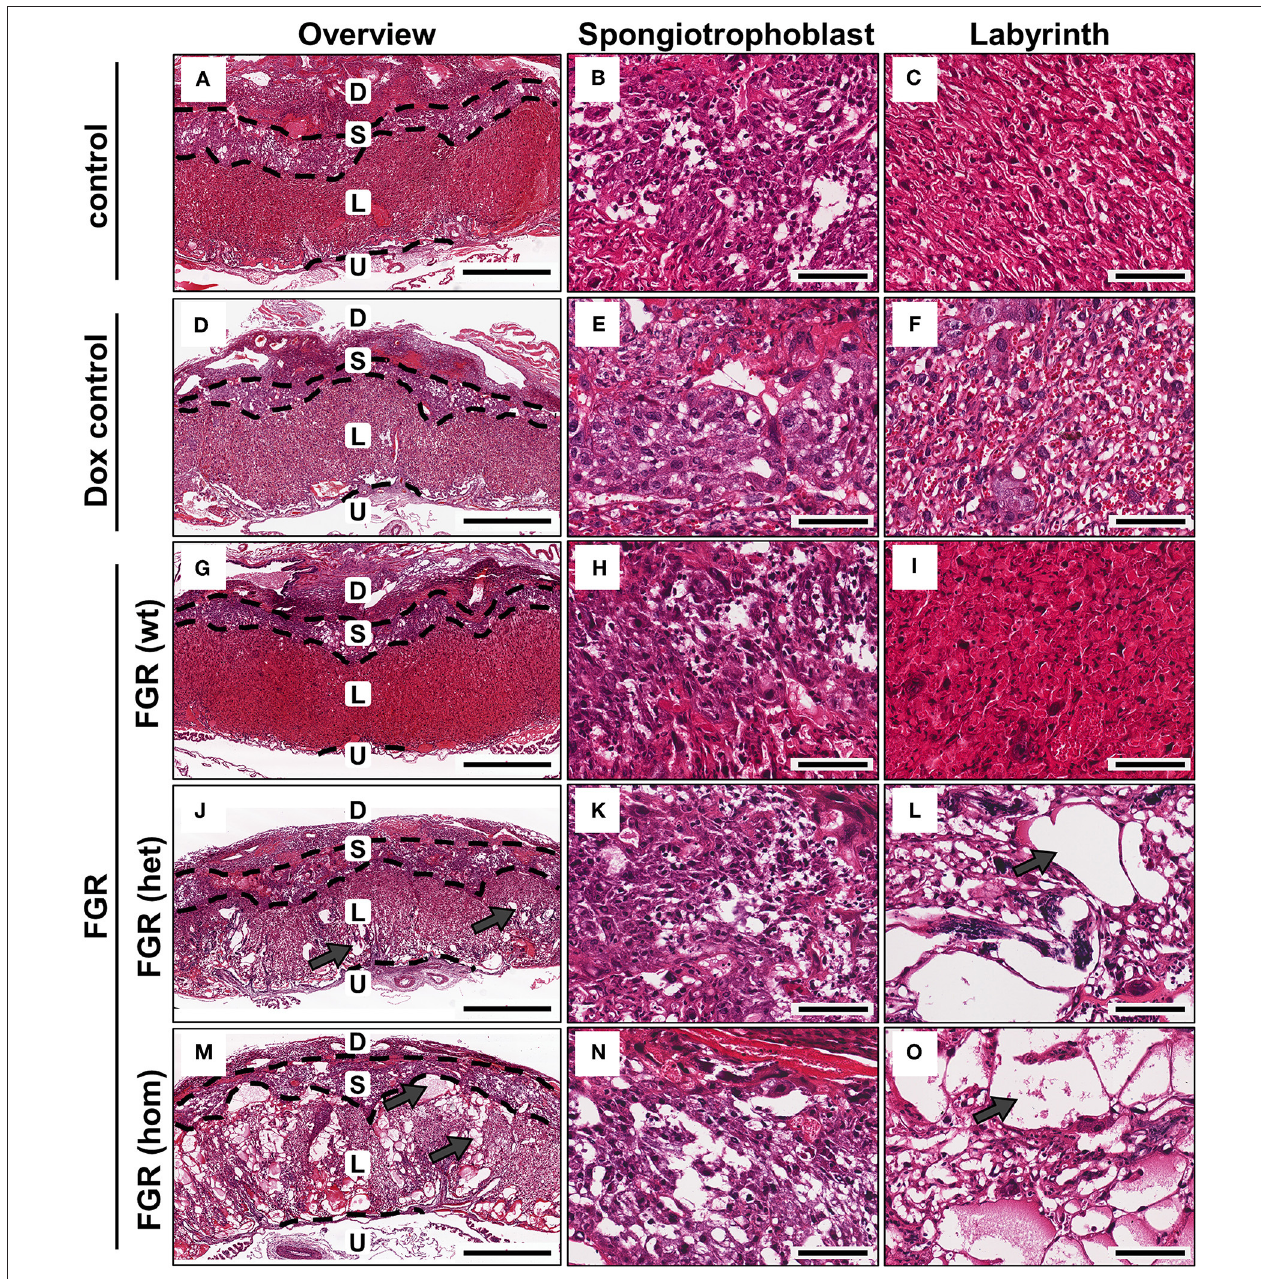
FIGURE 4 | Placental morphology at day 18.5 post coitum in the hsFLT1/rtTA mouse model. Placentas from the various experimental groups were collected and stained with hematoxylin and eosin (H&E). The following groups are shown either in 2 × overview (left) or in a 20 × detailed structure view of spongiotrophoblast (middle) and labyrinth (right): control [ n = 16 (A–C) ] and doxycycline (Dox) control placentas [ n = 12 (D–F) ], fetal growth restriction wild-type [FGR wt; n = 9 (G–I) ], FGR heterozygous het; n = 3 (J–L) and FGR homozygous placentas [hom; n = 10 (M–O) ]. High-expressing human soluble fms-like tyrosine kinase 1 (hsFLT1) FGR hom and FGR het placentas (maternal and placental hsFLT1 expression) exhibited enlarged blood-filled spaces (lacunas, indicated by gray arrows) within the entire placenta, but low-expressing hsFLT1 FGR wt placentas (with maternal hsFLT1 expression only), non-expressing hsFLT1 control placentas, and Dox control placentas did not exhibit such lacunas [ (A,D) compared to (G,J,M) ]. The lacunas were located not only in the spongiotrophoblast [ (B,E) compared to (H,K,N) ], but also in the labyrinth of hsFLT1–expressing placentas [ (C,F) compared to (I,L,O) ]. Interestingly, the FGR wt placentas exhibited a phenotype with a morphology between those of FGR hom/het placentas and control placentas, in which the labyrinth compartment is more densely characterized by an intense staining pattern. Scale bar 2 × overview = 1,000 µ m; 20 × details = 100 µ m. D, decidua; L, labyrinth; S, spongiotrophoblast; U, umbilical cord.